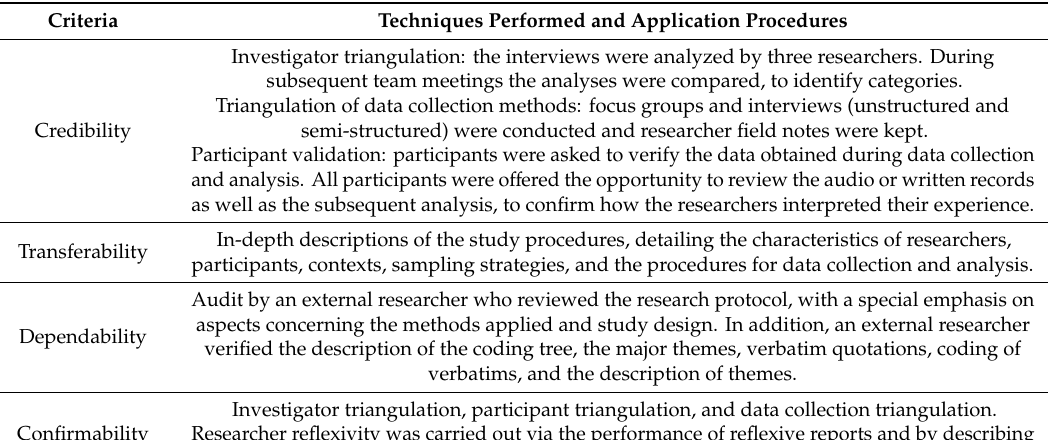
Table 3. Trustworthiness criteria.